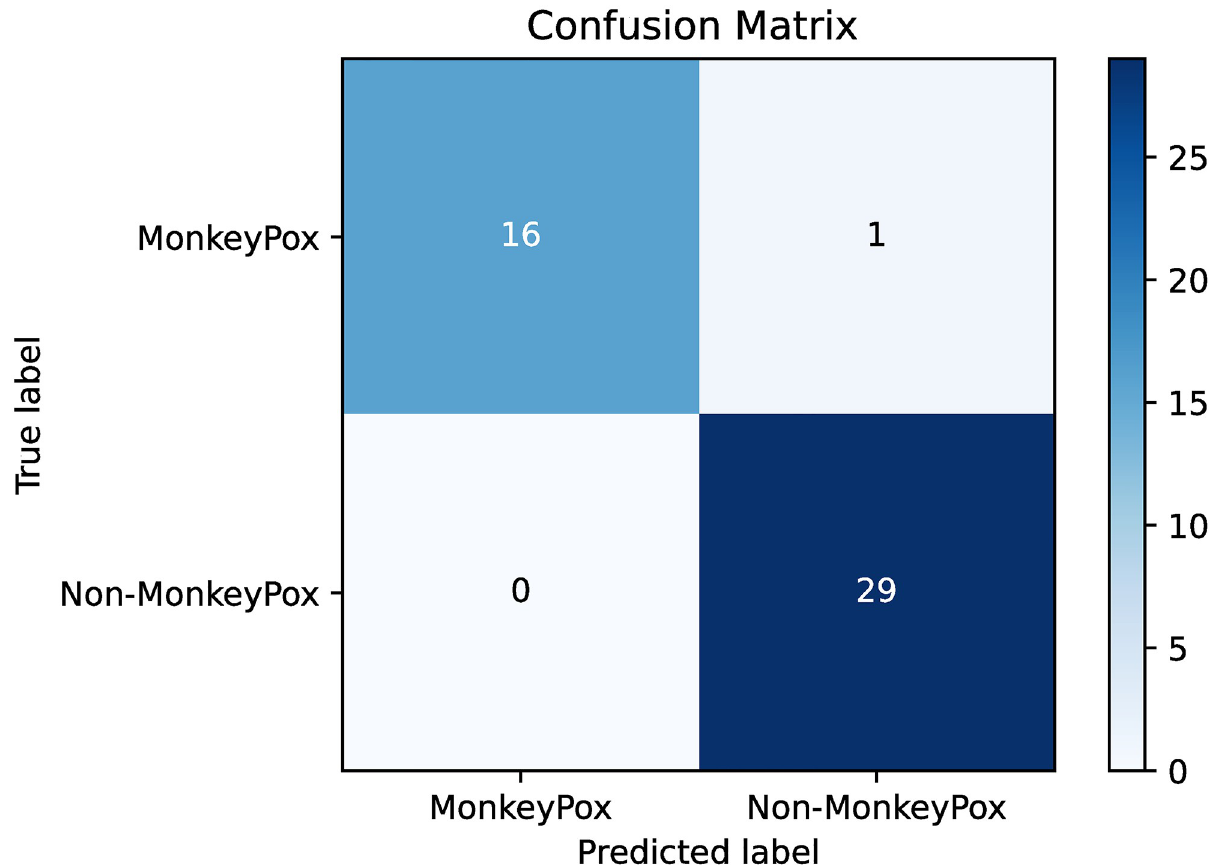
Fig 8. Post-ensemble confusion matrix for Fold-1 of the